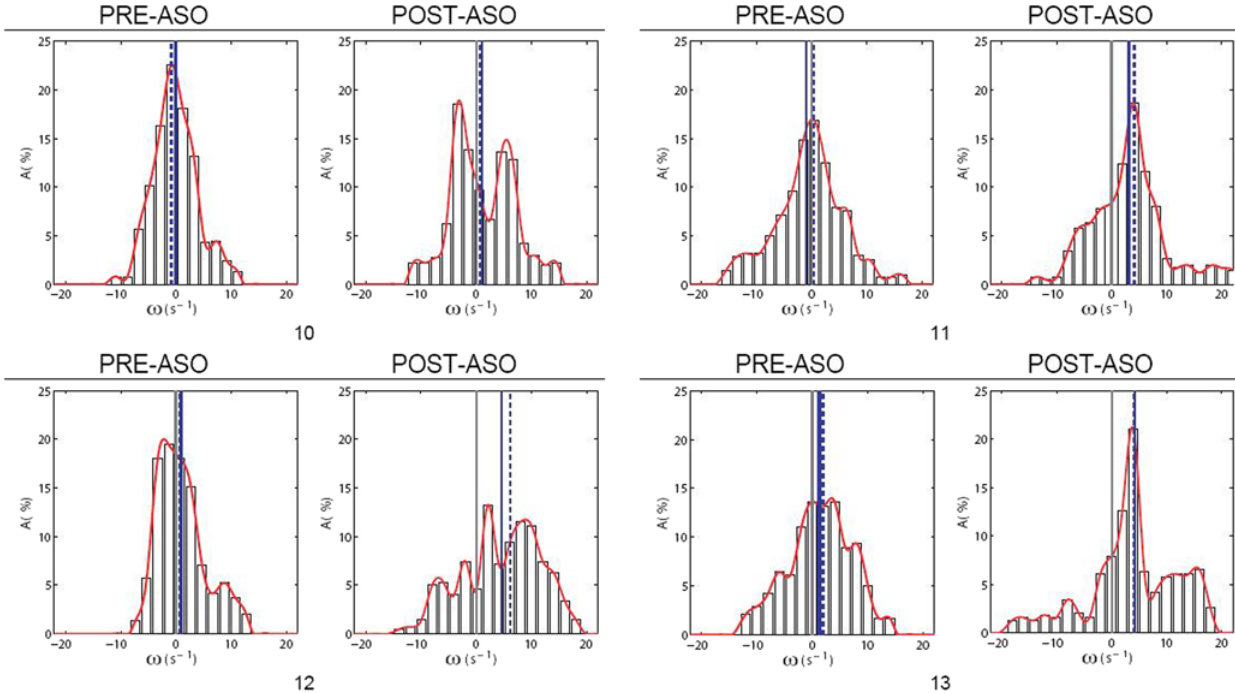
Figure 5. Histograms of vorticity maps for right atrial flow pre- and post-ASO. The histogram represents the distribution of vorticity values in a map. Statistical parameters used include means v 1 , v 2 and standard deviations s 1 , s 2 obtained from the histograms of the vorticity maps, with the subscripts 1 and 2 representing pre- and post-ASO conditions respectively. The mean is a gauge of the average angular velocity throughout the flow, and the standard deviation measures the variability of vorticity measures.